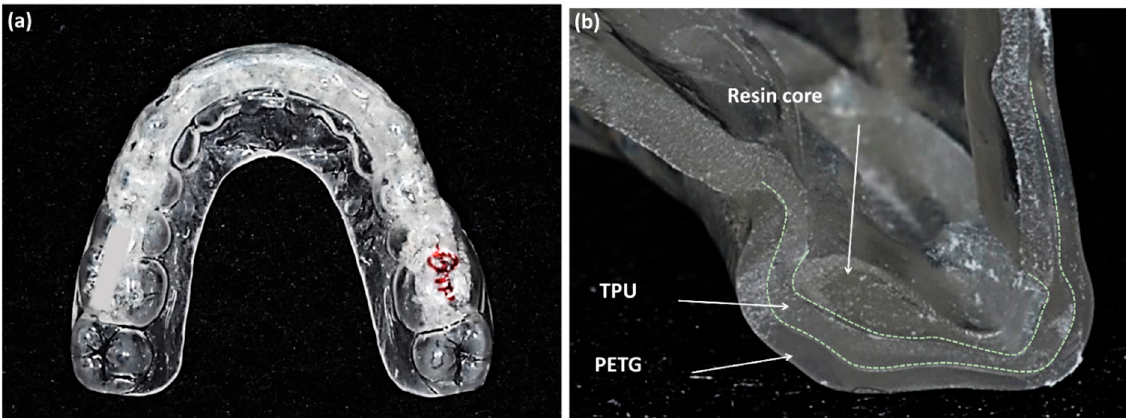
Figure 1. ( a ) Oral-treaper (OTP) retainer for maxillary dentition; ( b ) the three layers of the OTP on the incisor at the sliced surface, reinforced resin core, thermoplastic polyurethane (TPU), and polyethylene terephthalate glycol (PETG) (Forestacryl and Track B thermoforming foils, Forestadent, Bernard Förster GmbH, Pforzheim, Germany).